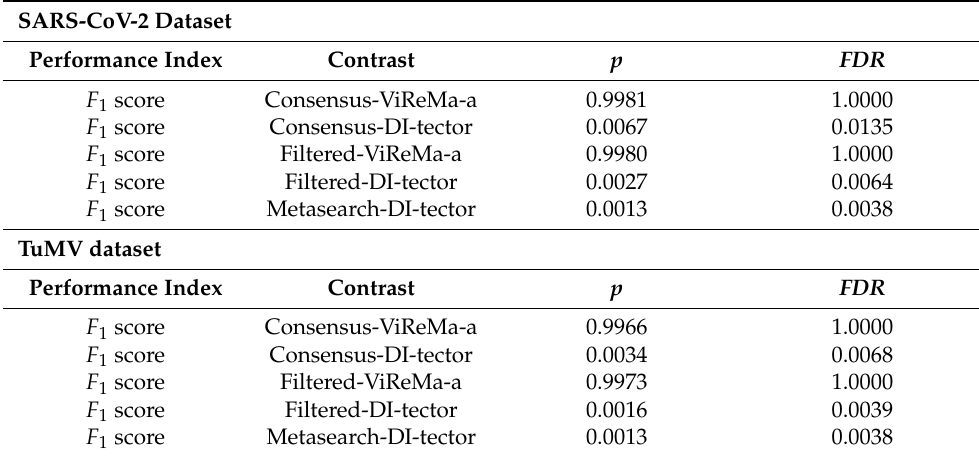
Table 6. Pairwise comparisons (Wilcoxon signed rank test for paired samples) for F 1 score in both sets of synthetic samples. The one-tailed contrast is shown in the contrast column. The p -value was corrected with Benjamini-Hochberg FDR .